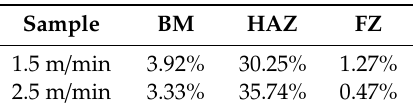
Figure 6. The misorientation distribution of HAZs under the welding speed of ( a ) 1.5 m/min and ( b ) 2.5 m/min. The inverse pole figures (IPFs) and average grain size of FZ in welded joints are shown in Figure 7. It can be observed that the grain size at 1.5 m/s welding speed was larger than that at 2.5 m/s welding speed (Figure 7c). During the cooling process, the larger secondary dendrite arm consumed the smaller secondary dendrite arm by growing and coarsening, due to the chemical potential difference caused by the difference of curvature and interface energy of crystal. Therefore, the shorter the local solidification time of the molten metal and the faster the cooling rate, the smaller the dendrite grain size [36]. In other words, the increase of welding speed increases the cooling rate of FZ, resulting in a decrease of the average grain size of dendrite grains. The annealing twins inside the dendrites